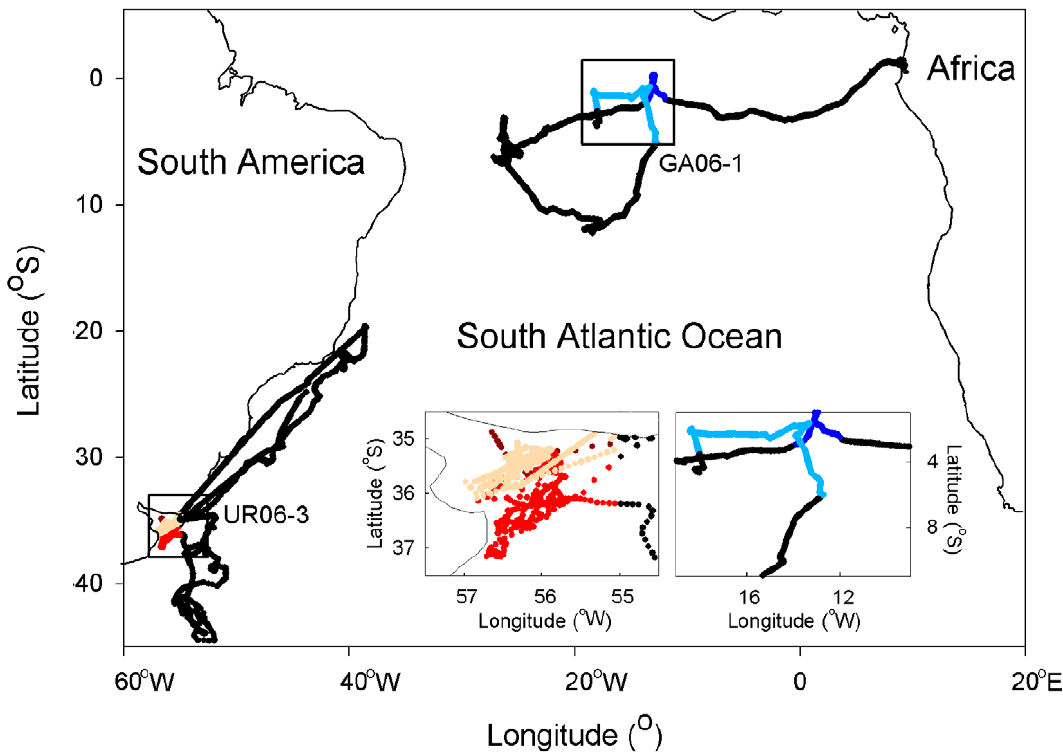
Figure 2. Fidelity to Temporary Residence Areas. Illustrative examples of fidelity to Temporary Residence Areas (TRAs) in leatherback turtles during their pluri-annual migration. After nesting in Gabon in March 2006, GA06-1 reached a first oceanic TRA (TRA13) by May 2006 (right insert, dark blue track) that she reached again by May 2007 (light blue track) after a counter-clockwise long loop in the middle South-equatorial Atlantic. After being released in the Rio de la Plata estuary in October 2006 (left insert, brown track), UR06-3 moved southward into oceanic water before coming back to her neritic TRA: the Rio de la Plata estuary (TRA21) by February 2007 (red track) that she reached again by January 2008 (orange track) after migrating north toward Brazilian waters close to the Victoria-Trinidad seamount chain. Each year, UR06-3 resided during 3 months in the Rio de la Plata estuary (TRA21).